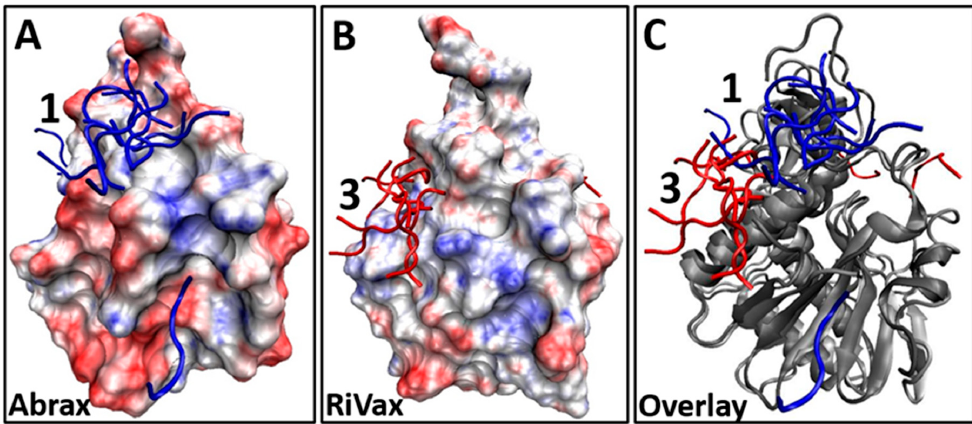
Figure 5. ( A , B ) Surface representation showing electrostatic potential (red = electronegative, blue = electropositive) and binding locations of the top 10 decoys for Tier 1 consensus sequence FWDTWF binding, found using XPairIt, to: ( A ) abrax (top 10 decoys are blue sticks); and ( B ) RiVax (top 10 decoys are red sticks); ( C ) Overlay of the abrax and RiVax images from ( A ) and ( B ) using ribbon protein backbone (in gray for both abrax and RiVax) to show that the binding locations of the consensus are different. Table 3. Pocket Volume (in cubic angstroms) at Each Binding Location on Abrax or RiVax (Shown in Figure S5) for Tier 1 Peptides A5, A12, A14, and A15 Determined Using Fpocket.